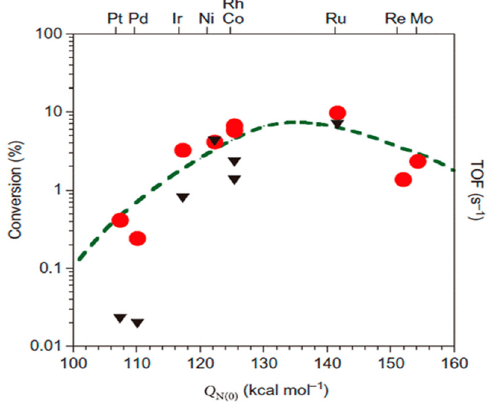
Figure 29. Comparison of turnover frequencies (TOFs) of supported catalyst for ammonia decomposition by modeling (circles, left axis) and experimenting (triangles, right axis) at 850 K. Reprinted with permission [115].